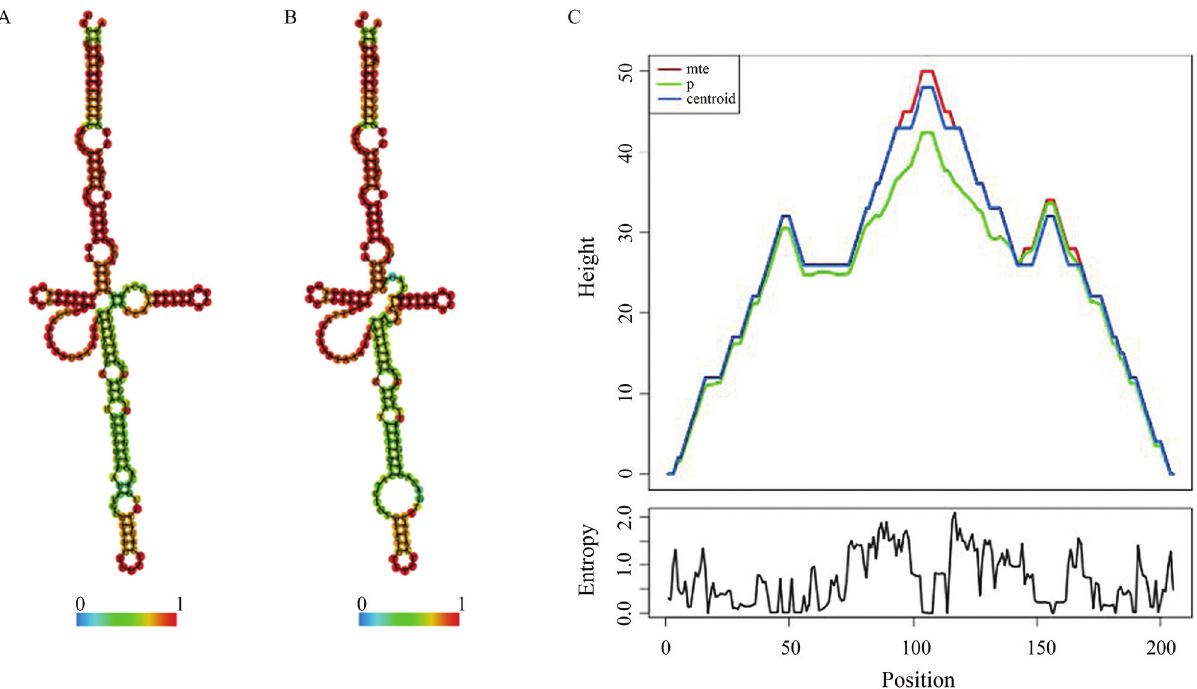
Figure 6 - RNA structure analysis obtained with RNAfold. A) Minimum free energy predicted structure (-84.39 Kcal/mol). B) Centroid secondary struc- ture.Inbothimagescolorintensitydenotesbase-pairingprobabilities.Forunpairedregionscolorisrelatedtotheprobabilityofbeingunpaired.C)Moun- tain plot of minimum free energy structure, the thermodynamic ensemble of RNA, centroid structures and entropy for each